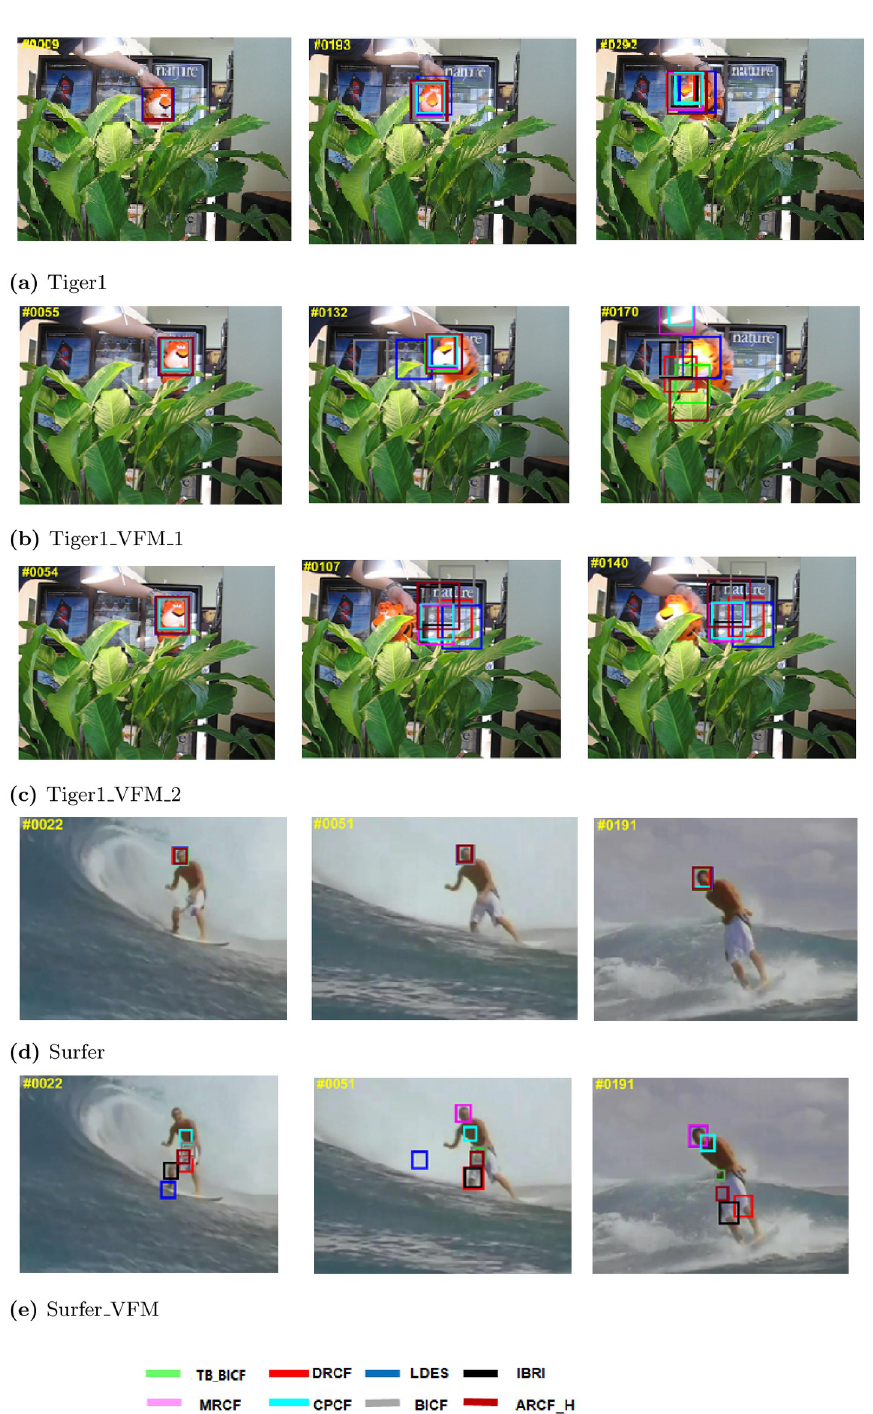
Fig 5. Qualitative assessment of the tested trackers on the a) Tiger1, b) Tiger1_VFM_1, c) Tiger1_VFM_2, d) Surfer, and e) Surfer_VFM sequences [8].